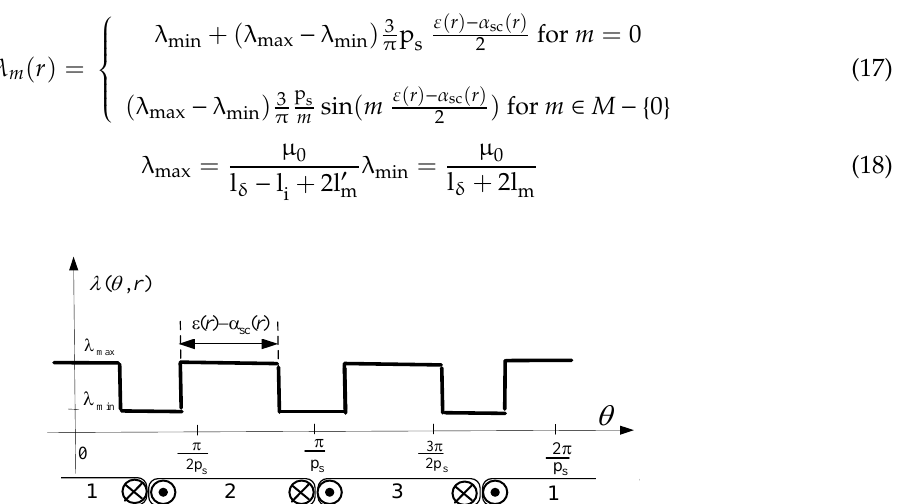
Figure 12. Unit permeance function AFPMG with stator cores.